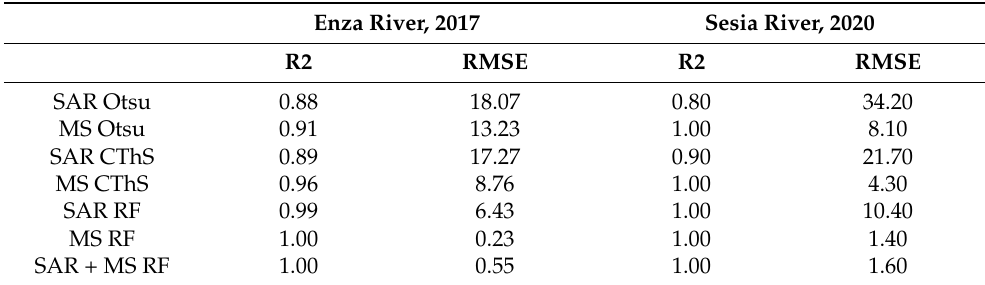
Figure 11. Plots of the fractional abundance of water (%) calculated over a regular 500 m resolu- tion grid for the flood event 2020 (Sesia river): results obtained by supervised and unsupervised methodologies ( x -axis) against a reference flood delineation ( y -axis). Table 6. Coefficient of determination (R2) and root mean square error (RMSE) calculated between the fractional abundance of water calculated from supervised and unsupervised classification methods vs. a reference flood